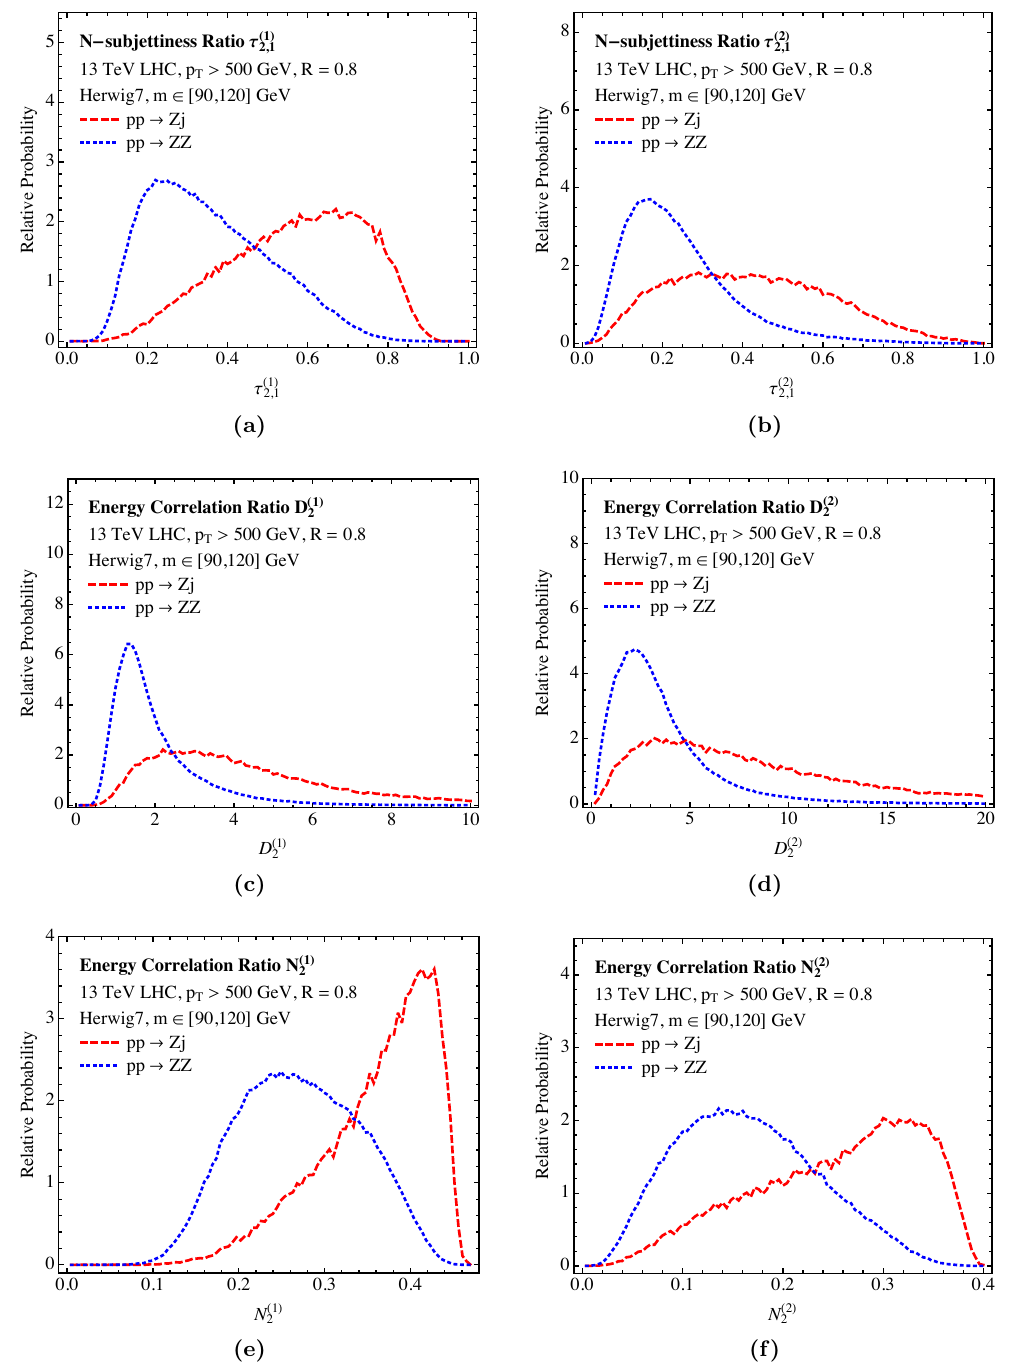
Figure 9. Distributions of various two-prong discrimination observables measured on the sample of jets showered with Herwig, on which a mass cut of m [90 ; 120] GeV has been placed. From 2 top to bottom are plotted signal (blue dotted) and background (red dashed) distributions of: N - subjettiness ratios (cid:28) (1) (left) and (cid:28) (2) (right), energy correlation function ratios D (1) (left) and D (2) 2 ; 1 2 ; 1 2 2 (right), and N (1) (left) and N (2) (right). 2 2